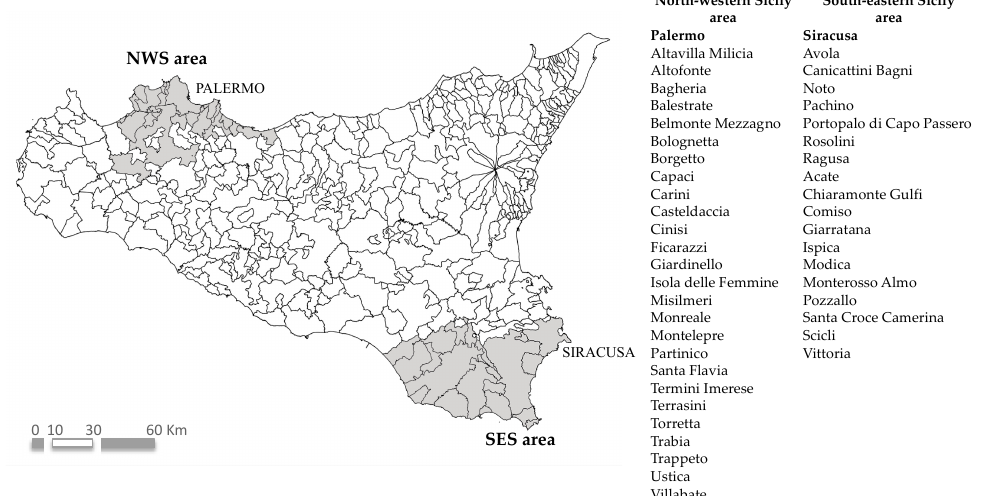
Figure 1. Geographical location of the north-western Sicily (NWS) and south-eastern Sicily (SES) areas in Italy.